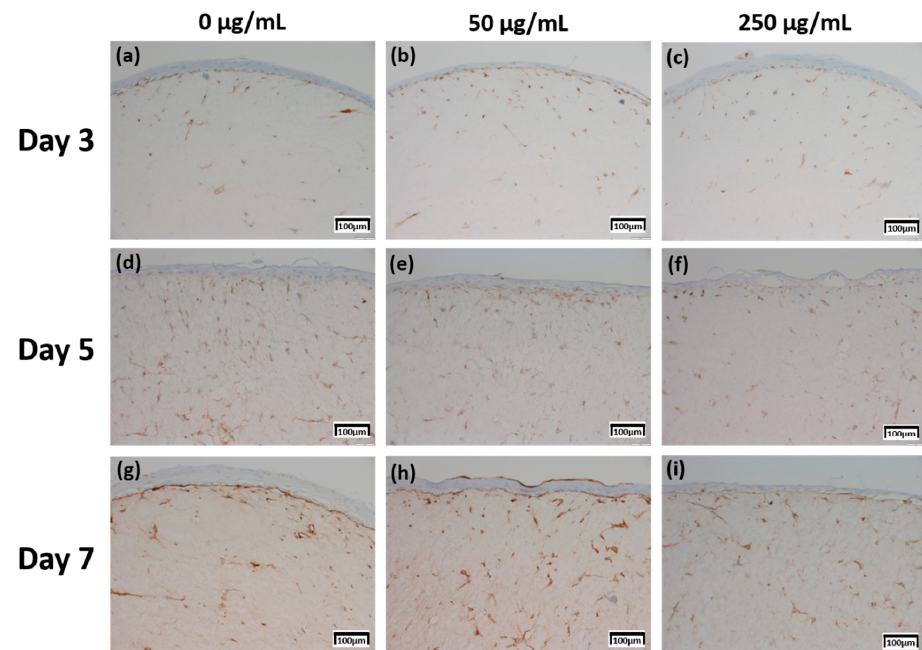
Figure 4. Immunohistochemistry stained images for fibronectin of 3D cell cultured sample for 3 days air exposure using culture media-treated CLLE concentrations of ( a ) 0 μ g/mL, ( b ) 50 μ g/mL, and ( c ) 250 μ g/mL; for 5 days air exposure using culture media-treated CLLE concentrations of ( d ) 0 μ g/mL, ( e ) 50 μ g/mL, and ( f ) 250 μ g/mL; and for 7 days air exposure using culture media-treated CLLE concentrations of ( g ) 0 μ g/mL, ( h ) 50 μ g/mL, and ( i ) 250 μ g/mL.